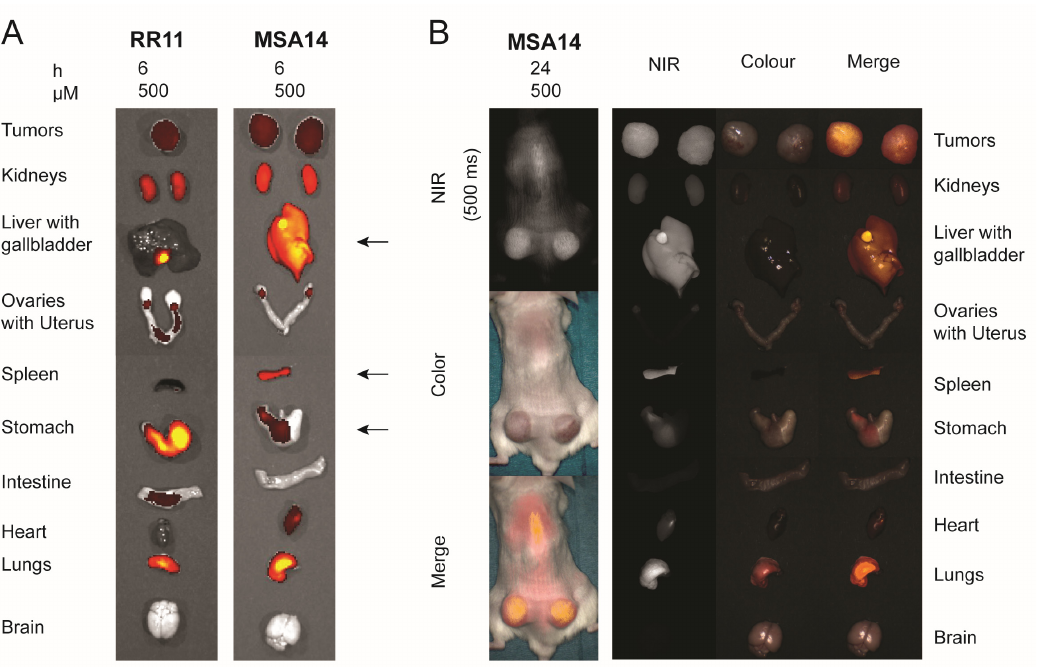
Figure 4. Organ biodistribution and intraoperative NIR FLI; ( A ) “Ex vivo” NIR FLI 6 h after 500 µ M injection of RR11 and 23 ( MSA14 ) was performed to assess the compound accumulation in tumors and organs. ( B ) Representative intraoperative near-infrared (NIR), color and pseudo-colored fluores- cent signal merge images of one 23 ( MSA14 ) injected subcutaneously engrafted OVCAR-3 mouse in vivo and ex